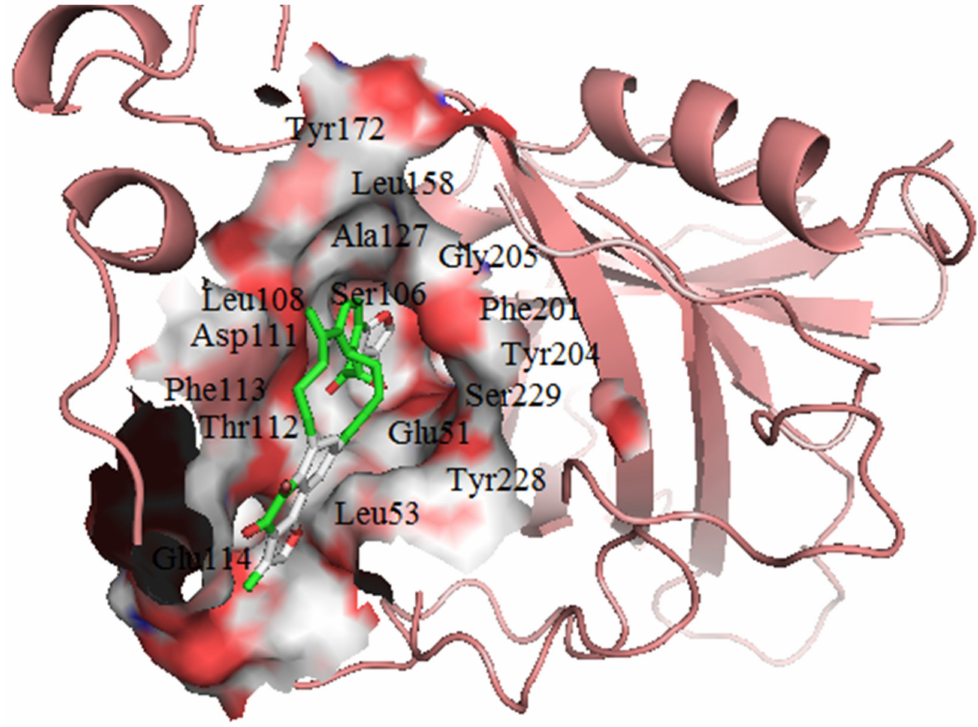
Figure 4. Cartoon representation of the WSP (model ROB2) in complex with ZINC000095913861. The binding sites are represented as surface and the ligands are shown as